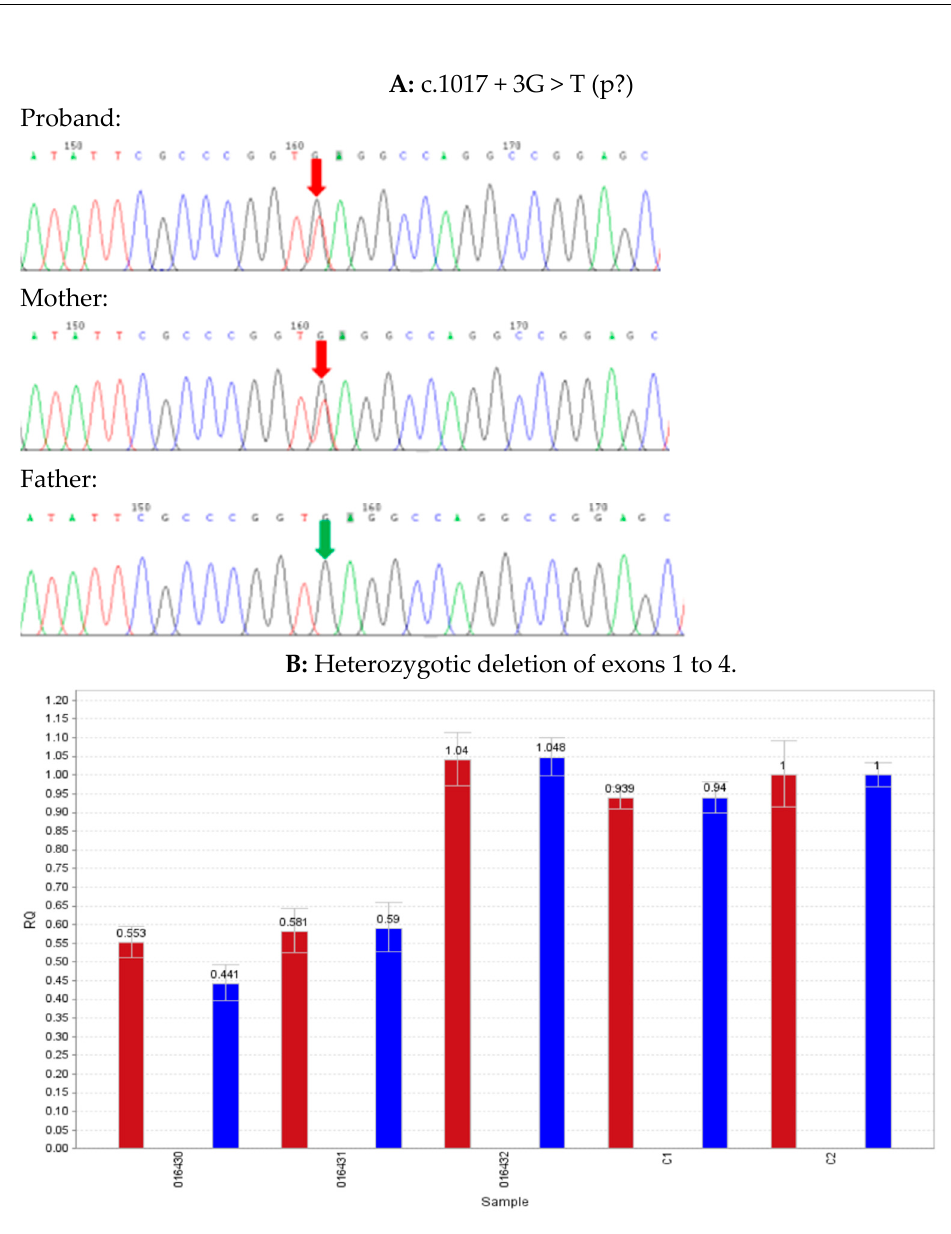
Figure 2. Summary of ACTL6B variants. ( A ) Sanger sequencing confirmed that the proband and its mother had ACTL6B c.1017 + 3G > T heterozygous variant, while the father was a wild type. ( B ) Quantitative polymerase chain reaction (qPCR) results: The QR values of the proband and its par- ents, ACTL6B gene E1, were 0.553, 0.581, and 1.04, respectively. The QR values of the proband and